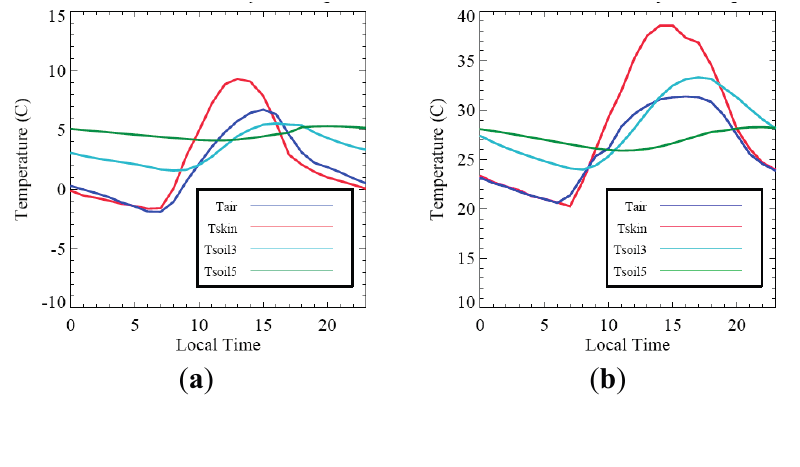
Figure 10. CLM4 simulated monthly mean T and T at the lower soil layer (T soil run is forced by ARM hourly